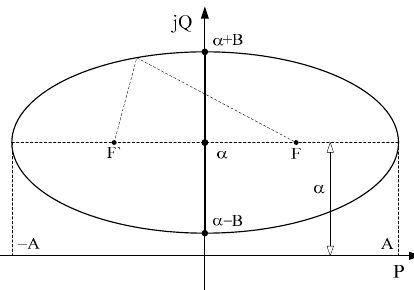
Figure 3. The trajectory of the complex power in a complex power plane.